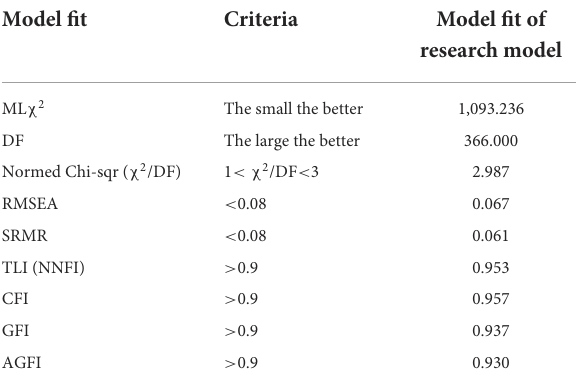
TABLE 5 Model fit criteria and the test